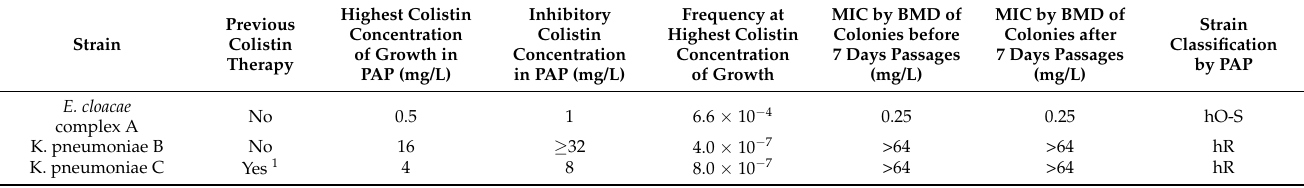
Table 4. Clinical aspects and the PAP results of the three isolates with false positive results obtained with the Rapid Polymyxin NP